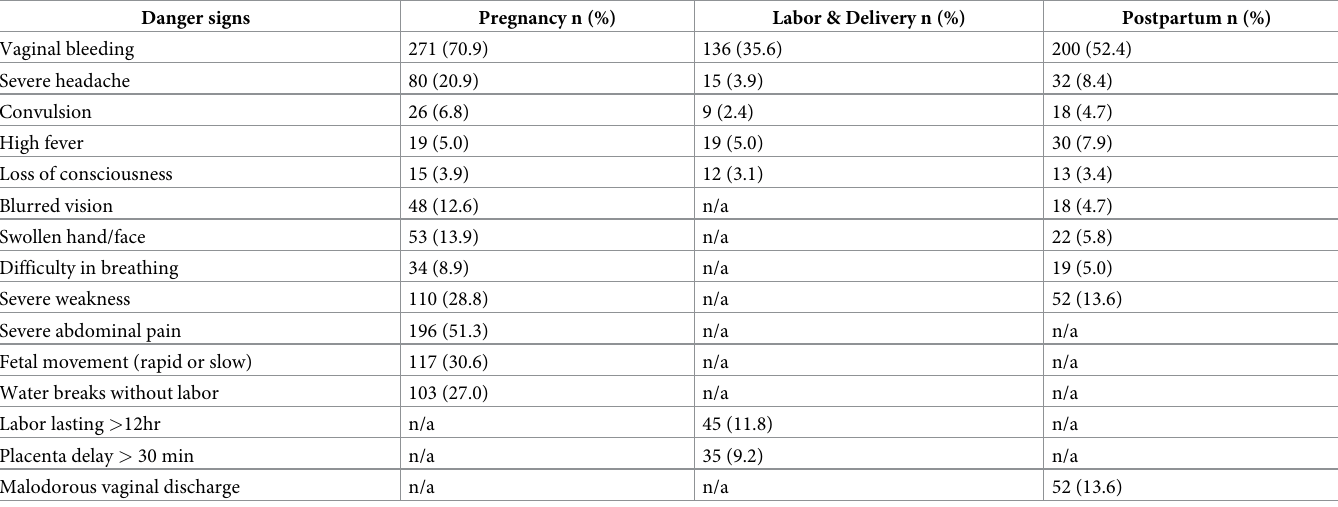
times, and 220 (57.6%) attended three ANC visits during the current pregnancy. Most partici- pants (43.2%) walked for more than 30 minutes to the nearest maternal health facility. Overall, the women’s knowledge of ODS during pregnancy, labor and delivery, and post- partum was 216 (56.6%), 35 (9.2%), and 67 (17.5%), respectively (Fig 1). The most recognized ODS during pregnancy were vaginal bleeding, 271 (70.9%), and severe abdominal pain, 196 (51.3%) (Table 2). The least recognized ODS during pregnancy were loss of consciousness, 15 (3.9%); high fever, 19 (5.0%); and convulsions, 26 (6.8%). During labor and delivery, the most recognizable ODS was vaginal bleeding, 136 (35.6%). Few participants, 45 (11.8%) and 35 (9.2%) recognized that labor lasting longer than 12 hours Table 2. Knowledge of ODS during pregnancy, labor and delivery, and immediately postpartum (n = 382). Danger signs Pregnancy n (%) Labor & Delivery n (%) Postpartum n (%) Vaginal bleeding 271 (70.9) 136 (35.6) 200 (52.4) 80